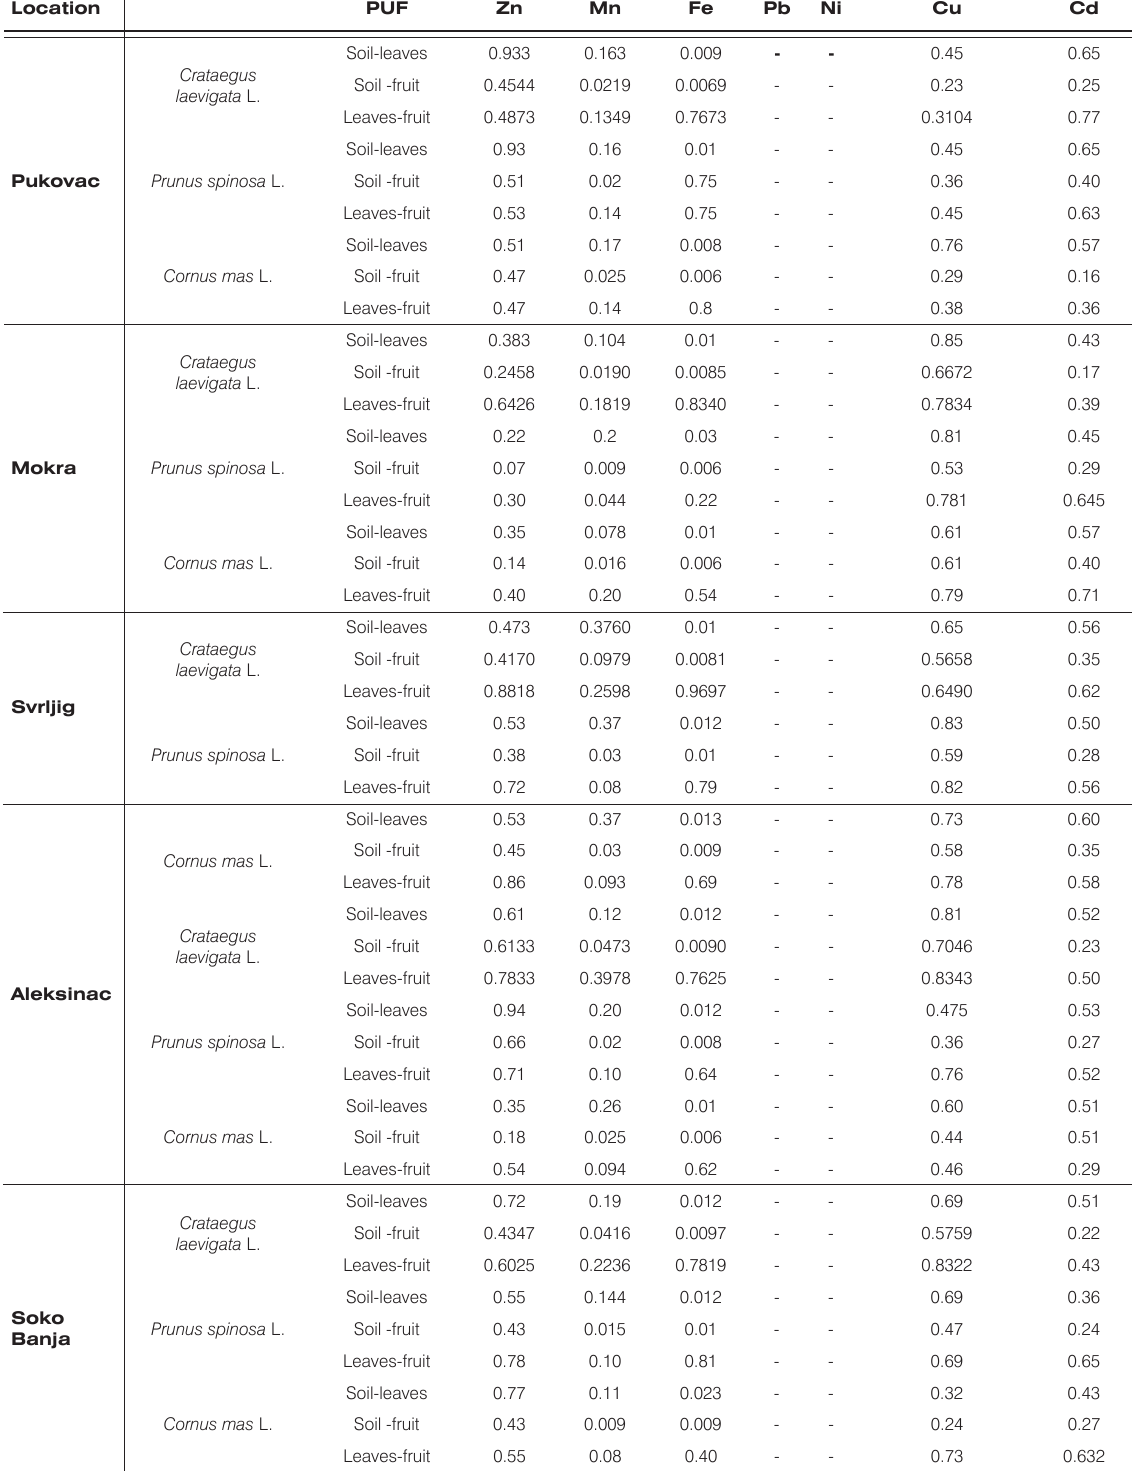
Table 4. PUF values.